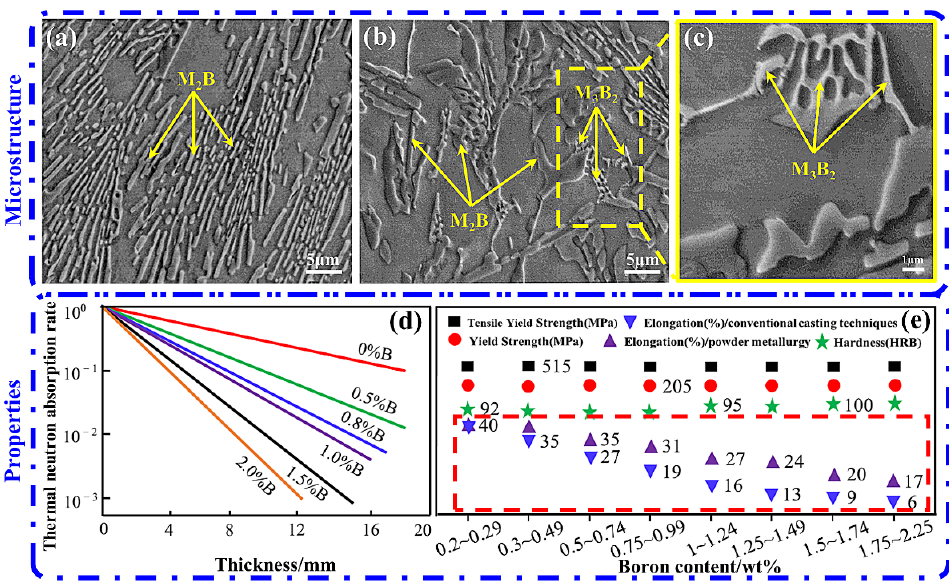
Figure 2. ( a ) Boride in 304 stainless steel, ( b ) boride in 316 stainless steel, and ( c ) M 3 B 2 of high mag- nification [23]; ( d ) variation of thermal neutron absorptivity with B content in borated stainless steels [22]; ( e ) variation of elongation with boron content in borated stainless steels